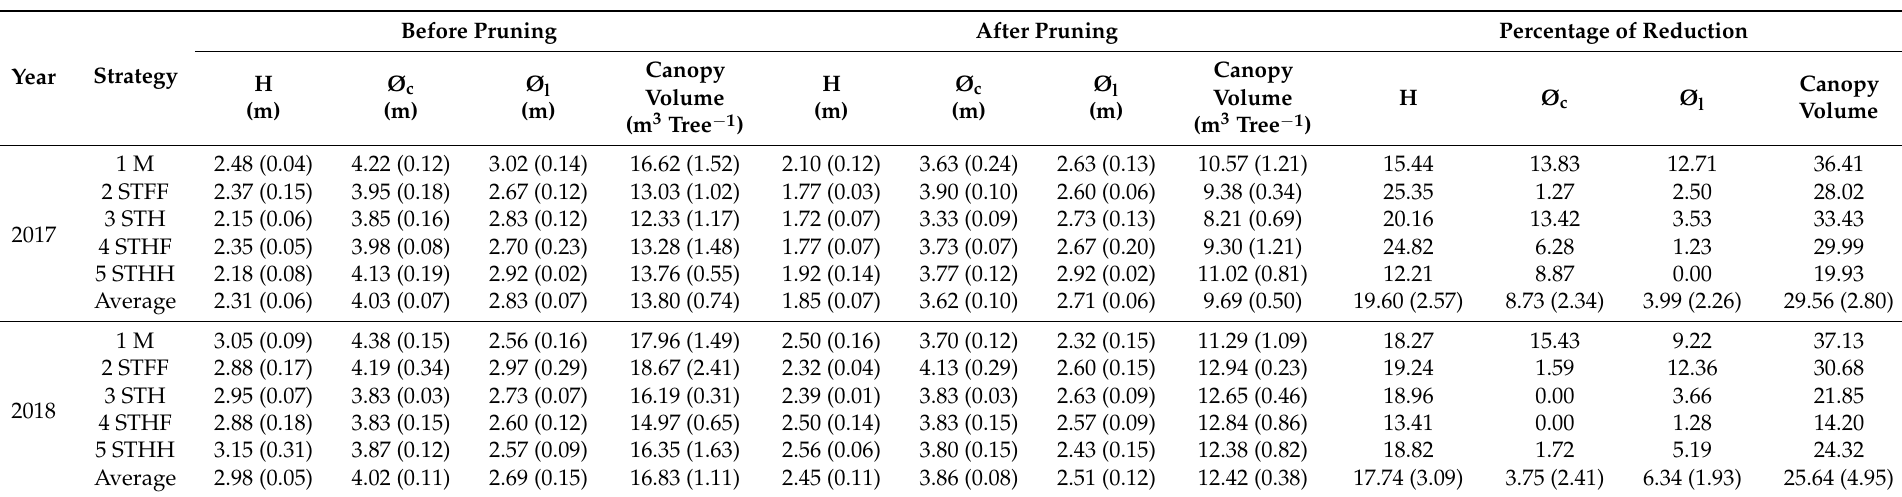
Table 4. Characterization of the canopy size before and after pruning and the percentage of reduction.